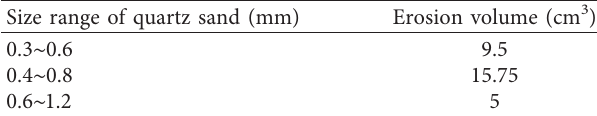
Table 4: Effect of abrasive grain size on the erosion performance. Size range of quartz sand (mm)